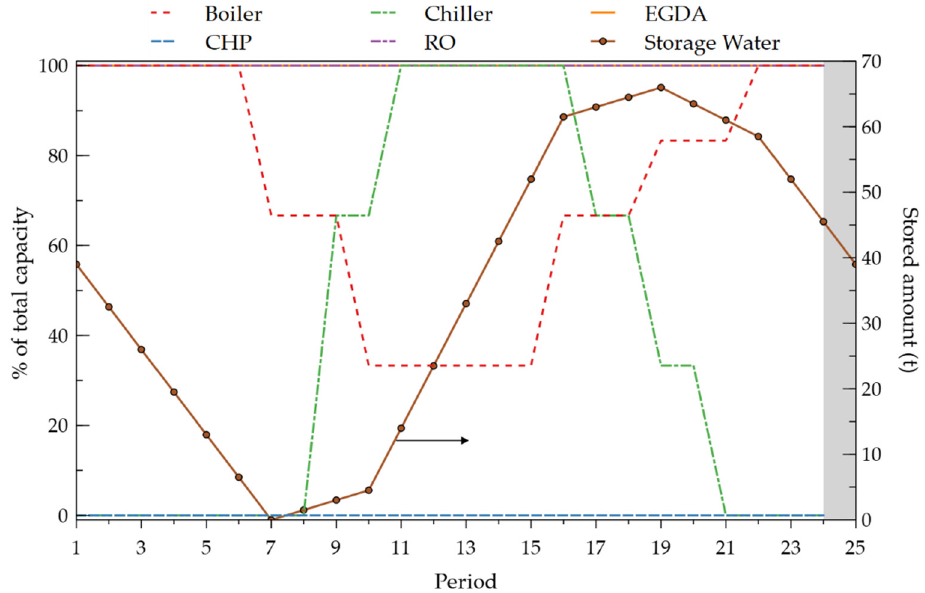
Figure 6. Operating state of the units for the different periods in most profitable solution with no CO 2 limitation.